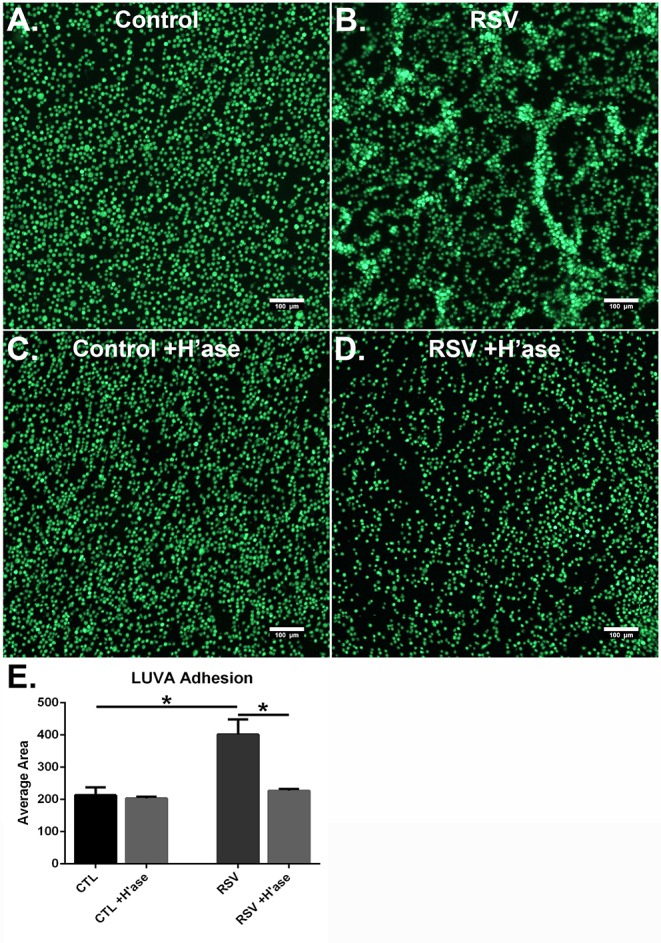
Adhesion of LUVA cells (green) to the ECM generated by (A) control HLFs compared to (B) RSV-infected HLFs. Note that LUVA cells aggregated in clusters in a pattern similar to that shown in Figure 2. Panels (C,D) depict LUVA binding following pre-treatment of the wells with Streptomyces hyaluronidase for control HLFs and RSV-infected HLFs, respectively. (E) Quantitative analysis of the staining area revealed a 2-fold increase in LUVA binding in adhesion studies conducted with RSV-infected HLFs compared to control HLFs (401.6 ± 18.94 units vs. 213.2 ± 9.818 units, *P < 0.0001). The enhanced binding was eliminated in samples pre-treated with hyaluronidase (*P < 0.0001). Data shown as mean ± SD for N = 6 replicates/group.